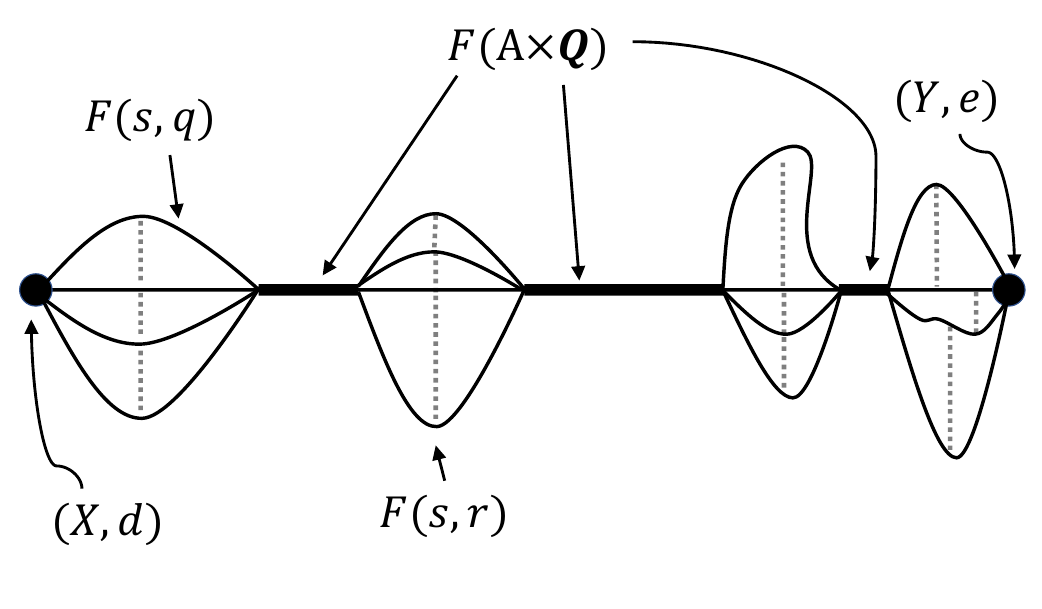
Figure 1: A -branching bunch of